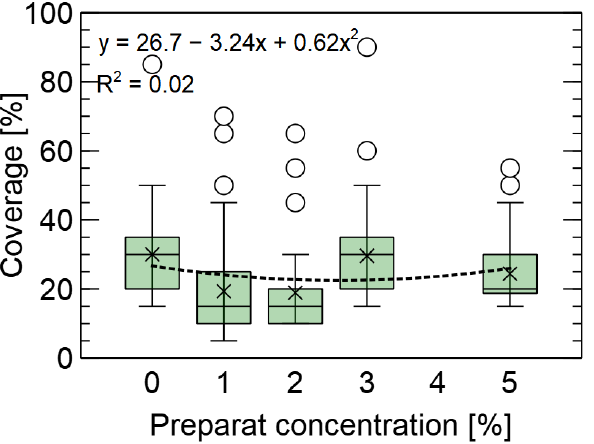
Figure 7. The degree of oak leaf tissue infection by powdery mildew versus silicon concentration. Measurements were performed at the end of the experiment. The dashed curve represents the linear regression fit of the data. The regression equation with the fitted parameters and the model’s R 2 values are printed in the figure. The regression parameters are statistically significant at the p -value of 0.023. In the plot, boxes span from the 1st to 3rd quantile, with the median indicated by a line, whiskers indicating a 1.5 inter-quantile range, the × symbol indicating the mean value, and circles indicating outlier